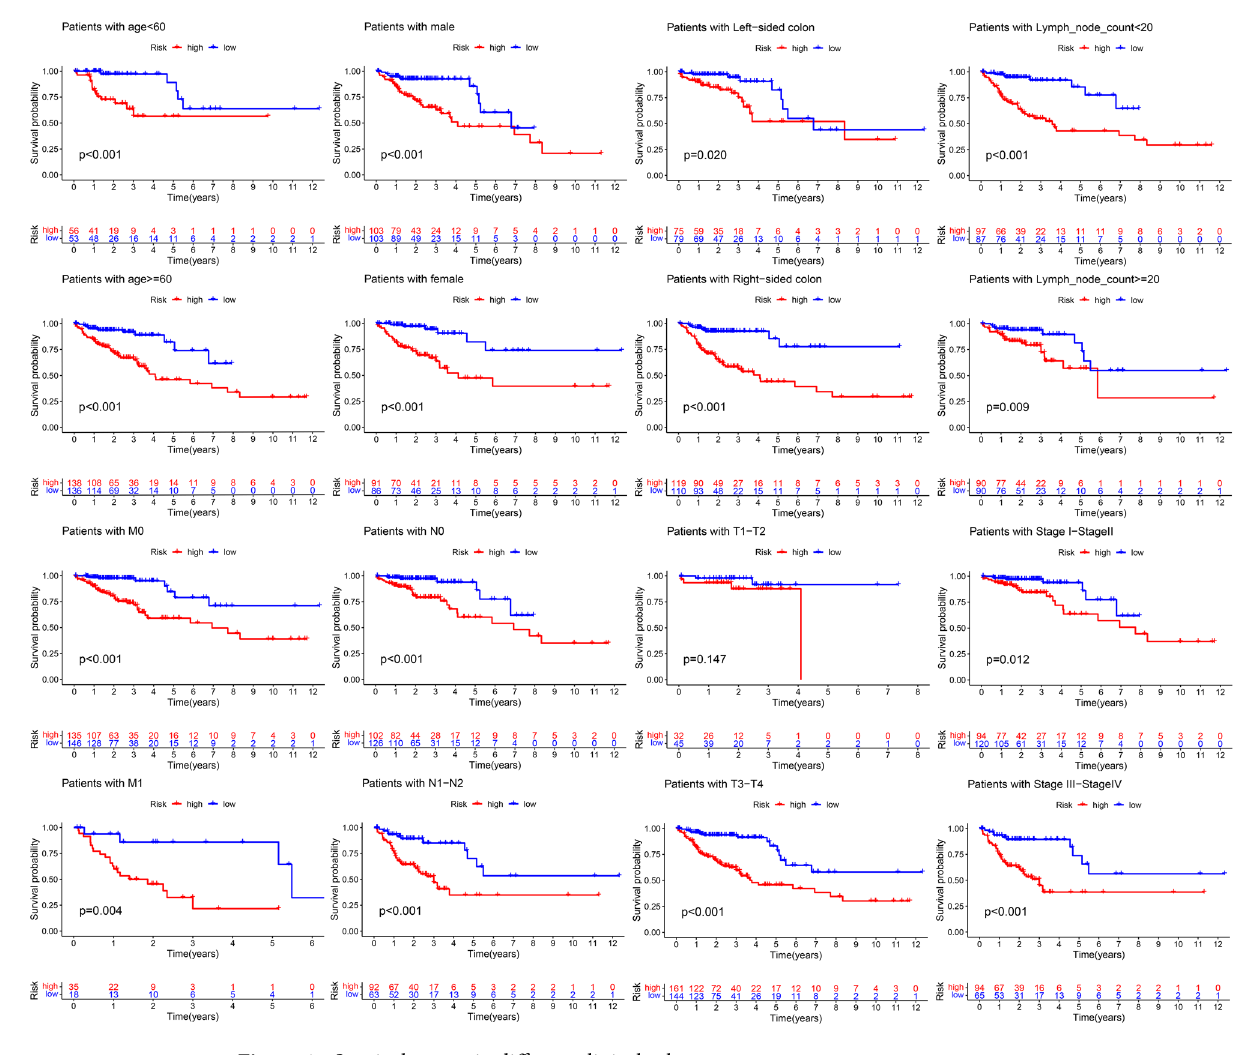
Figure 4. Survival curves in different clinical